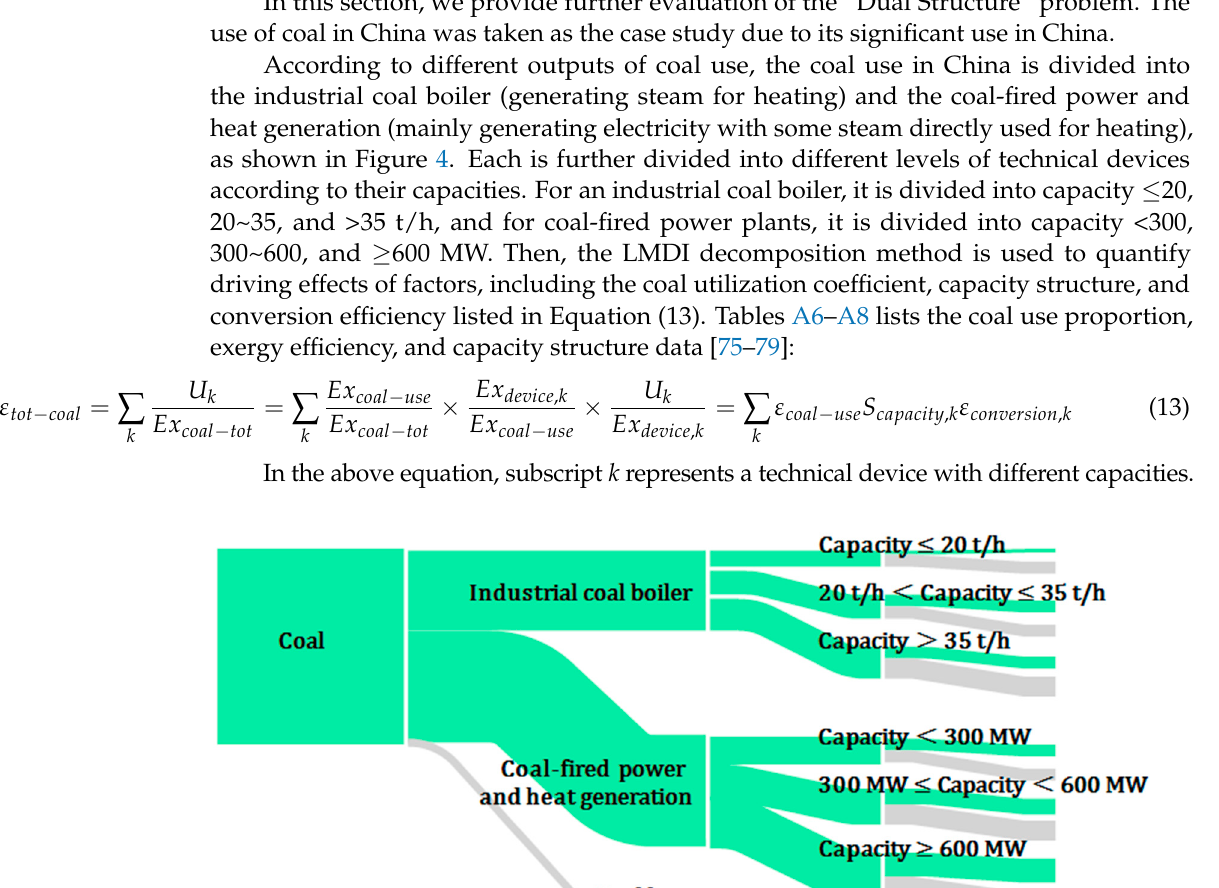
Figure 5. Exergy efficiency Sankey diagram from the energy source to final service of China in 2005.